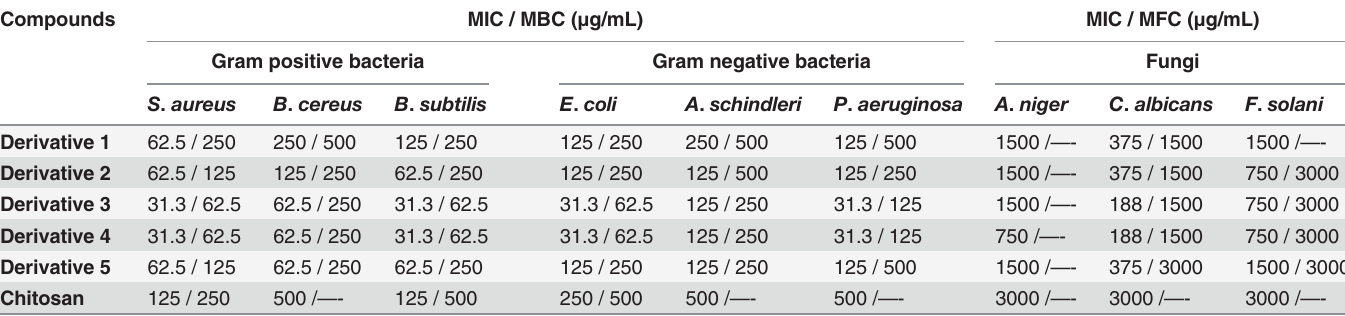
Table 3. Antibacterial and antifungal activity of chitosan and derivatives. (n = 3).